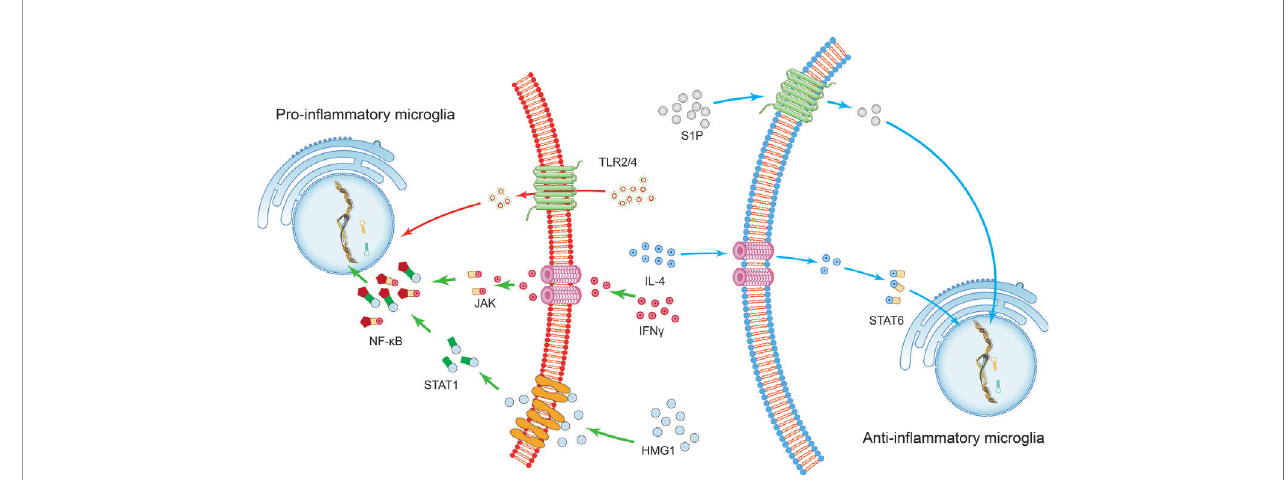
FIGURE 1 | The induction of microglial polarization by several transcription factors. Activation of high mobility histone 1 (HMG1) and Toll-like receptor (TLR) 2 or TLR4 promotes the pro-in fl ammatory phenotypic polarization of microglia. Interferon-gamma (IFN- g ) promotes the pro-in fl ammatory phenotypic polarization of microglia through the signaling sensors signal transducer and activator of transcription (STAT) 1 and Janus kinase (JAK). This series of processes involves the nuclear factor kappa B (NF- k B) signaling pathway. On the other hand, STAT6 accumulates under the action of IL-4 and is responsible for the transcription of M2 phenotype-related genes. The sphingosine-1-phosphate (S1P) receptor signaling pathway downregulates the expression of pro-in fl ammatory cytokines and enhances anti-in fl ammatory responses following intracerebral